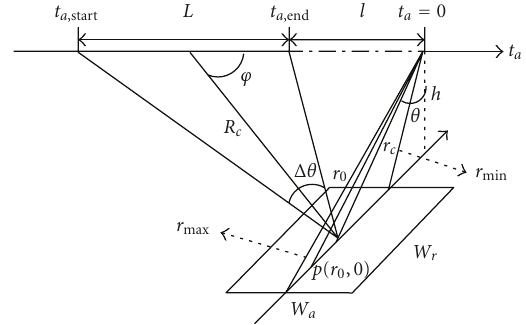
Figure 1: Squint-mode spotlight SAR